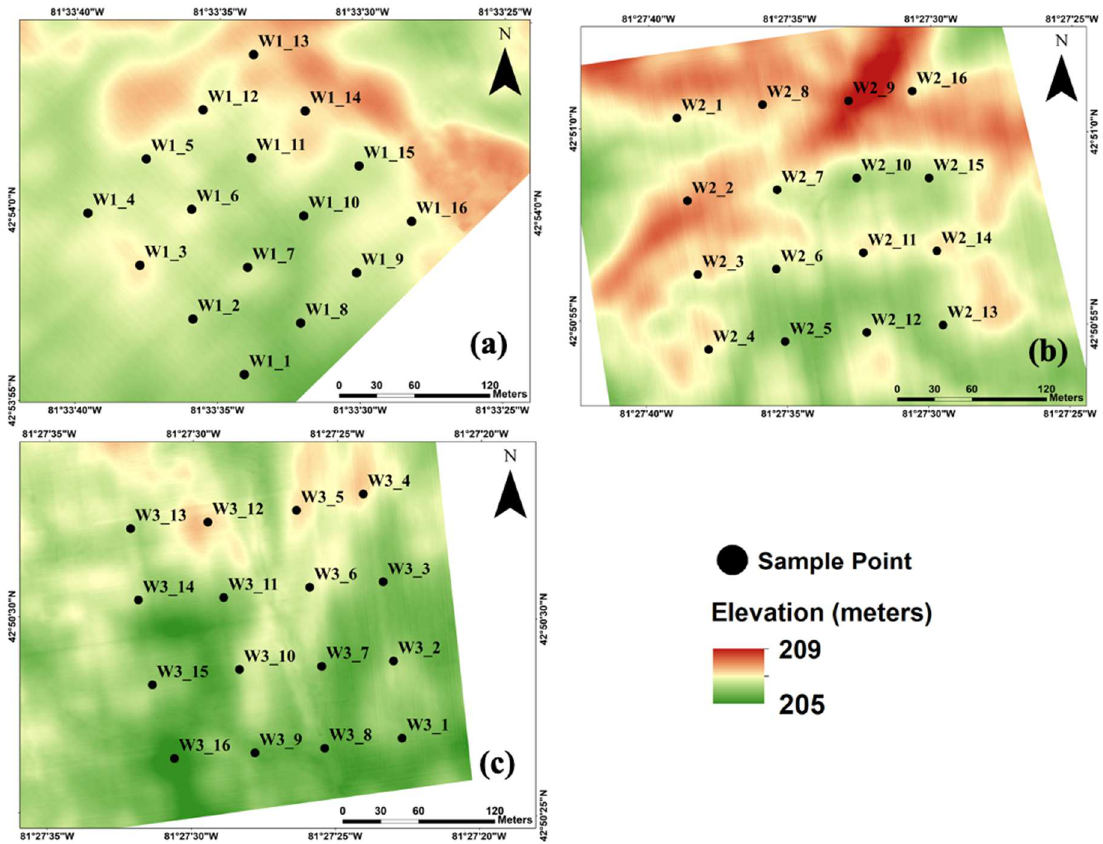
Figure 2. Digital elevation model showing the variation of the wheat field’s topography at each sample point for ( a ) W1 field, ( b ) W2 field, ( c ) W3 field. sample point for ( a ) W1 field, ( b ) W2 field, ( c ) W3